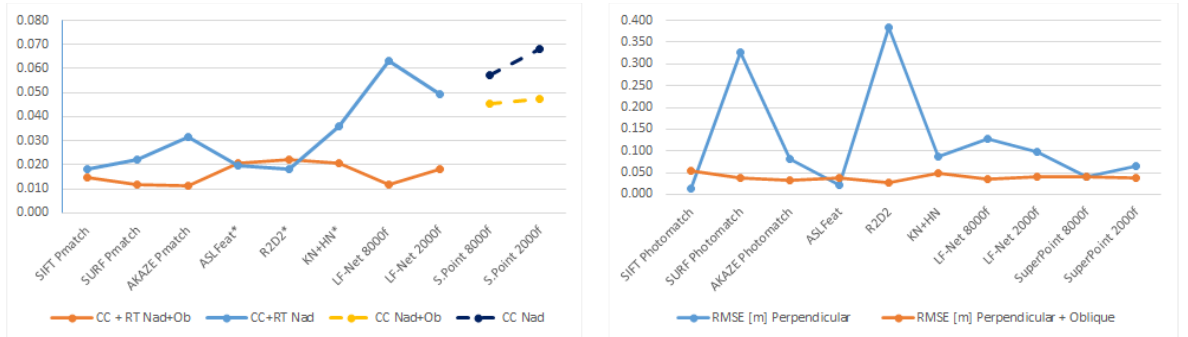
Figure 8: RMSE [m] for the Paestum Wall . SURF and R2D2 produced a pronounced curvature/deformation - not visible from the MRE analysis – in case of only perpendicular images. The use of oblique images reveals a minimal RMSE differences between the various